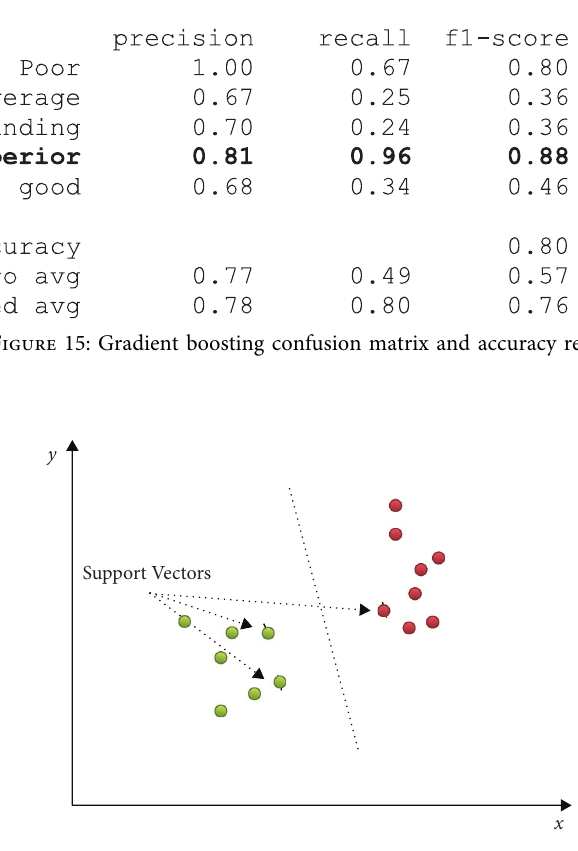
Figure 16: SVM hyperplane that differentiates two